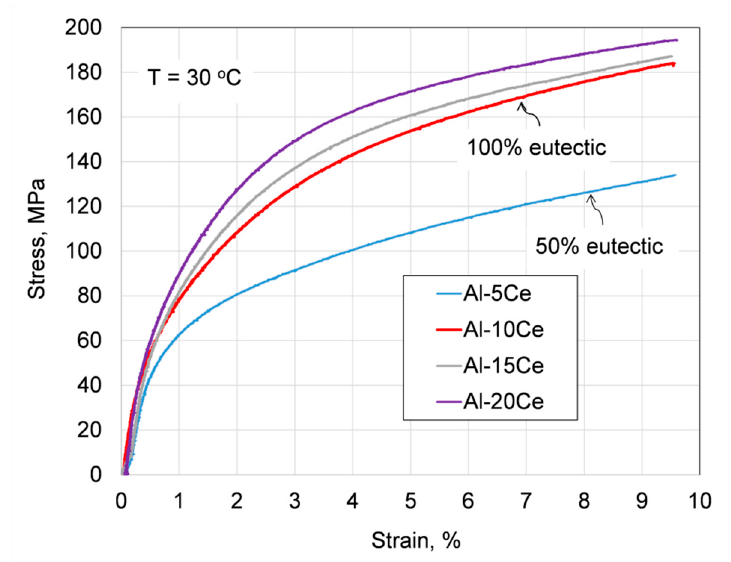
Figure 20. The engineering stress–strain plot for the room temperature compression of the as-cast Al–Ce alloys, showing the effect of Ce content. Yield stress determined: Al–5Ce– σ 0.2 = 53 MPa; Al–10Ce– σ 0.2 = 71 MPa; Al–15Ce– σ 0.2 = 80 MPa; Al–20Ce– σ 0.2 = 89 MPa. alloy (Al–8.3Si–2.4Zn–0.2Mn wt.%) which relies on the Al–Si eutectic. A room temperature